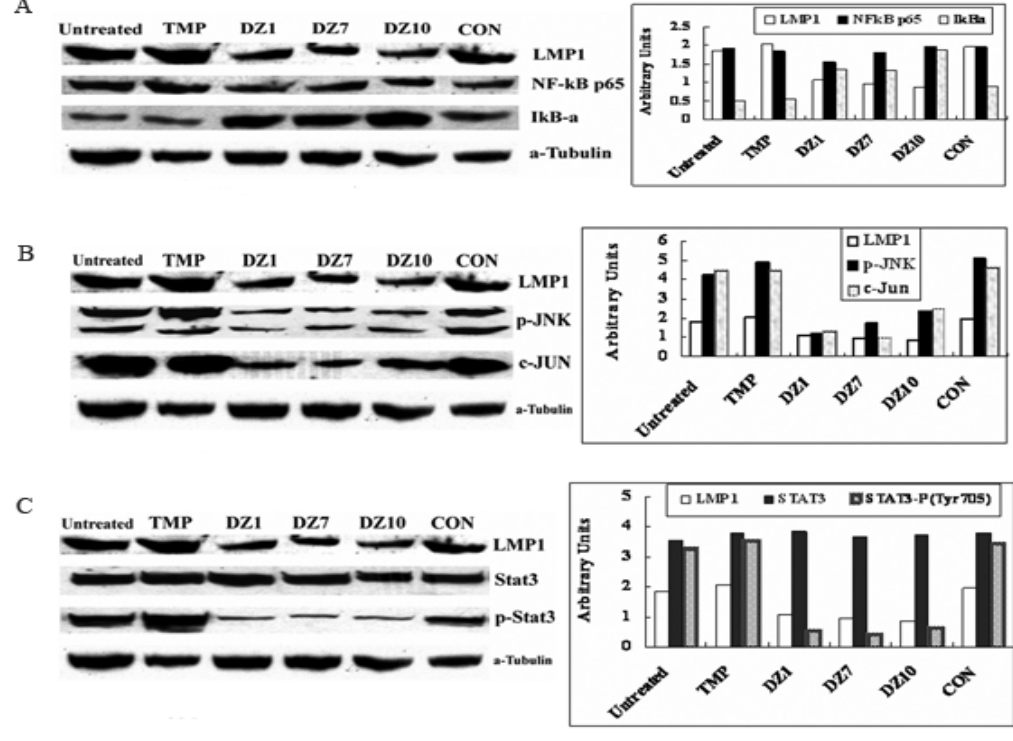
Figure 2. Effect of DNAzymes on NF- κ B, AP-1 and STAT3 signal transduction pathways in CNE1-LMP1 cells. Cells were transfected with DNAzymes or Control ODN for 24 h, total cell lysates were analyzed by Western blot respectively (left panel) and the protein expression level was quantitated by densitometry (right panel). (A) NF- κ B pathway; (B) c- jun/JNK pathway; (C) Stat3